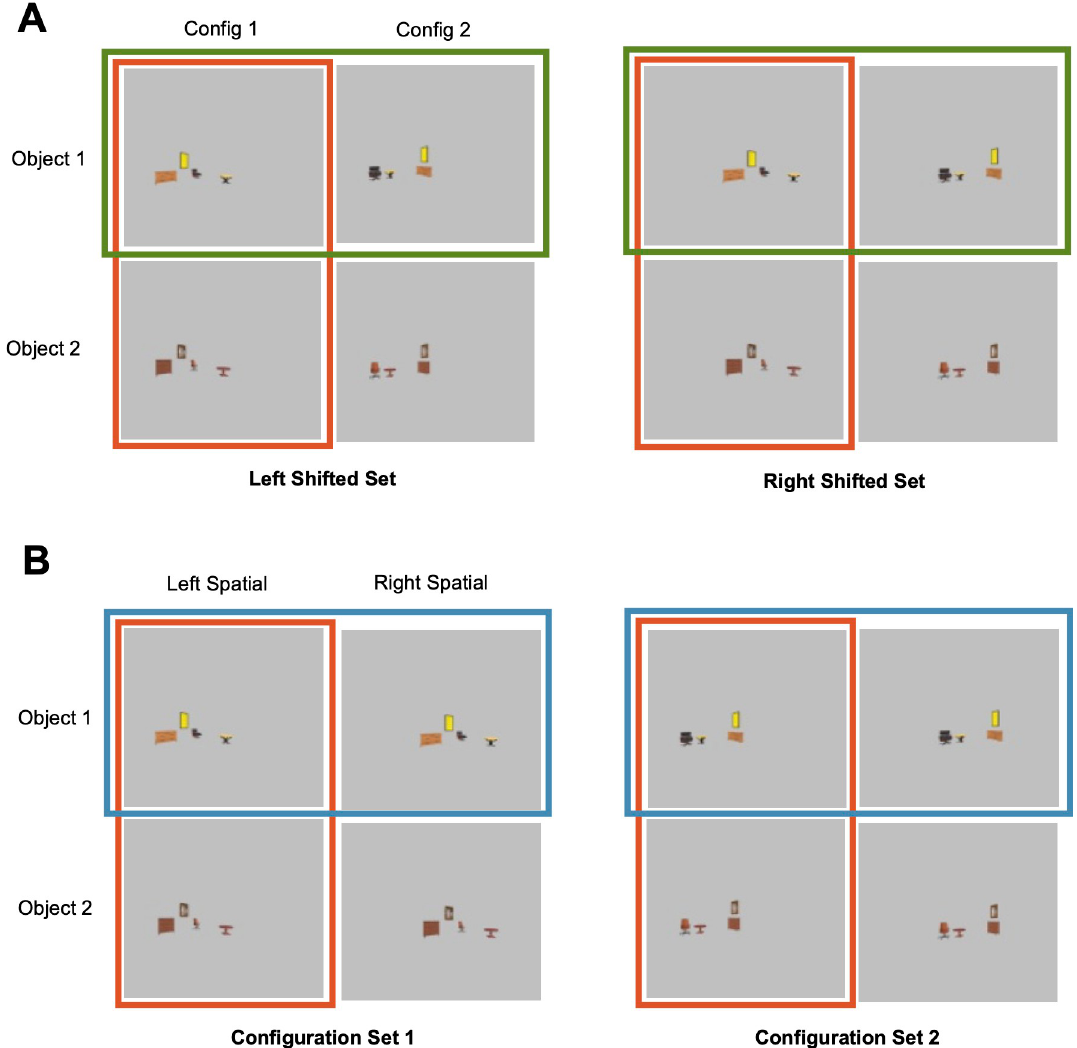
Fig 2. An example image set showing object configuration change and spatial shift within the same set of images. These images were modified from the “No Background” image set shown in Fig 1. Each image set contained eight different images varying in configuration, objects, and spatial shift. ( A ) The grouping of the images based on the direction of the spatial shift (left or right). In Left Shifted Set, all four images had the same amount of leftward spatial shift but varied in object identity and configuration (e.g., the two images in the red box varied in object identity and the two in the green box varied in configuration). The same applied to the images in Right Shifted Set. ( B ) The grouping of the images based on configuration. In Configuration Set 1, all four images had the same configuration but varied in object identity and spatial shift (e.g., the two images in the red box varied in object identity and the two in the blue box varied in spatial shift). The same applied to the images in Configuration Set